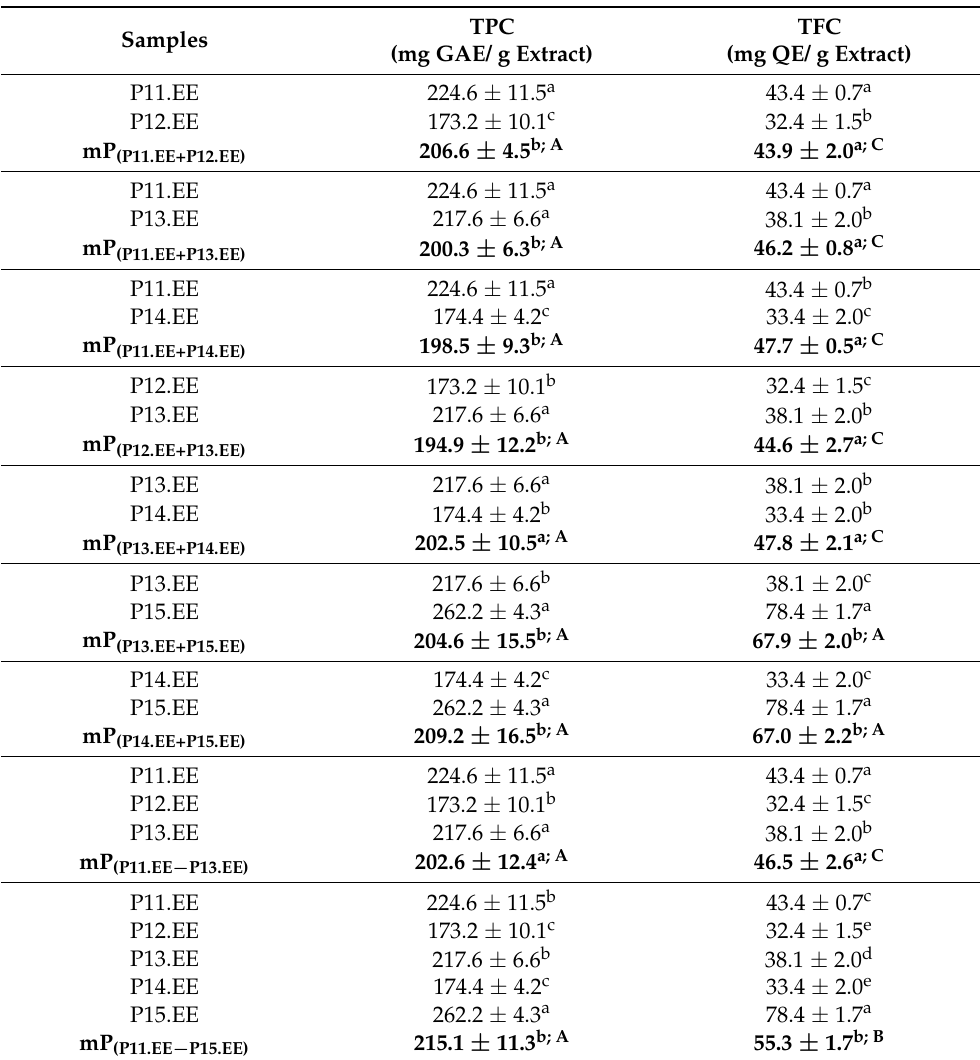
Table 1. Total polyphenols (TPC) and flavonoids contents (TFC) of the ethanol extracts of propolis harvested at Pereiro in the years 2011 to 2015 and of the mixtures of P.EEs prepared in this work. The results are presented as mean ± standard deviation of mg of gallic acid equivalents (GAE) and mg of quercetin equivalents (QE) per g extract (mg GAE/ g extract and mg QE/ g extract per g of extract), respectively. Significant differences ( p < 0.05) between TPC or between TFC of single extracts (P.EEs) and mixtures of extracts (mP.EEs) are noted with different lowercase letters. Significant differences between TPC or between TFC of mP.EEs ( p < 0.05) are represented with different uppercase